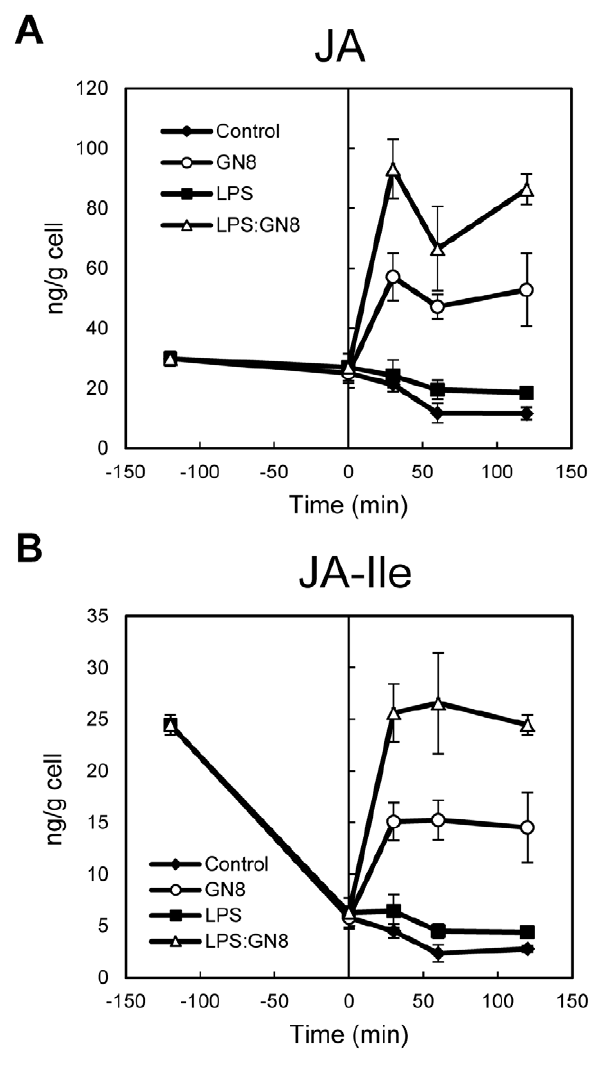
Figure 2. Cellular responses primed by LPS pretreatment. (A, B) Changes in JA and JA-Ile concentrations during LPS pretreatment and after successive GN8 treatment. Both GN8-induced accumulation of JA and JA-Ile were clearly primed by LPS pretreatment, though the concentrations of these compounds did not change during the pretreatment. Experimental conditions were the same to Fig.